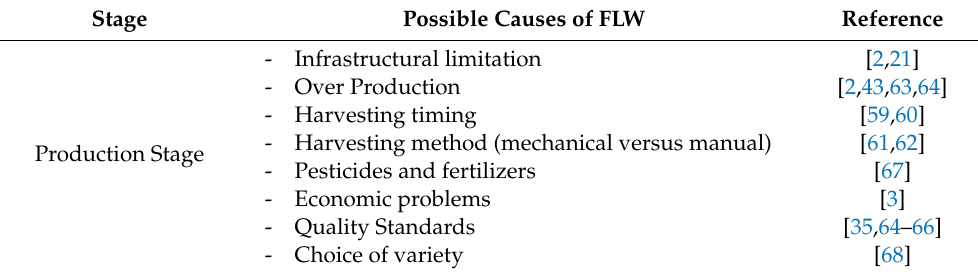
Table 6. Possible causes of FLW at the production stage of